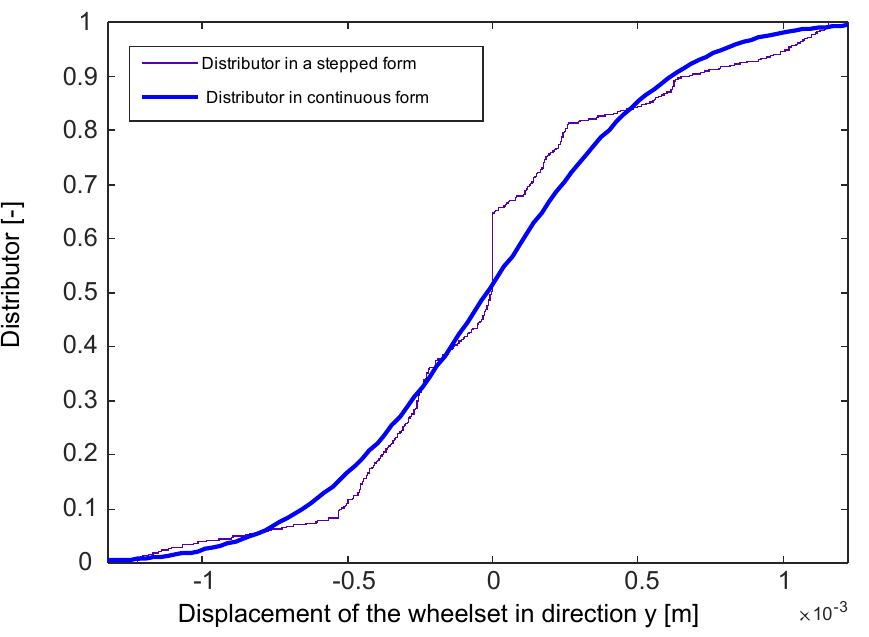
Figure 13. Distribution function for the displacement of the wheelset in y direction indicated for a